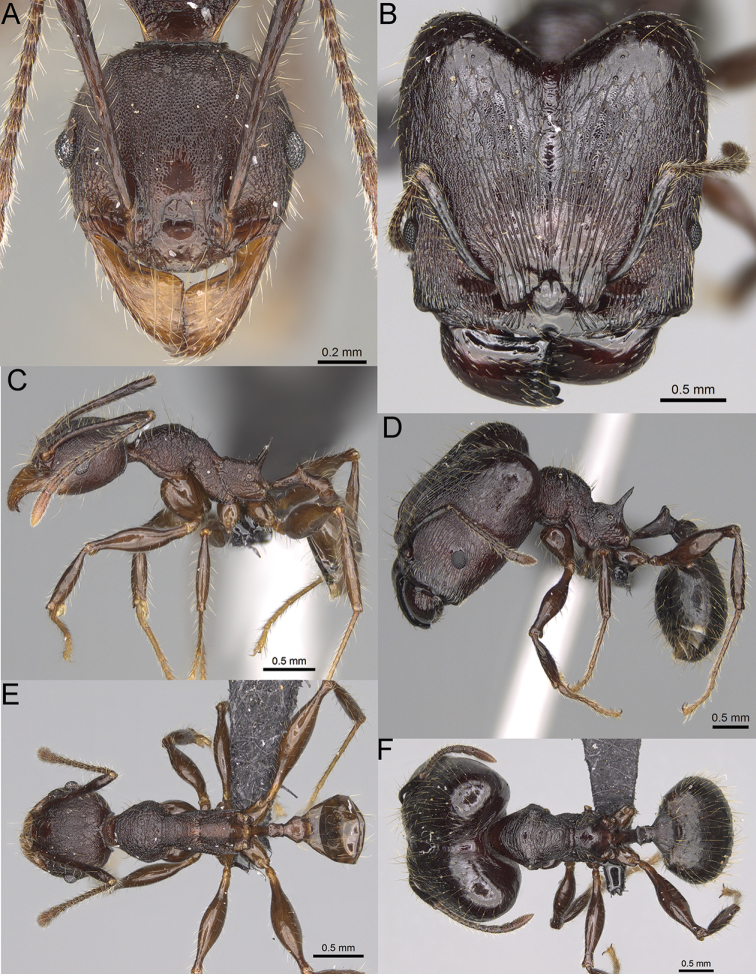
Pheidole
maizina sp. nov., full-face view (A), profile (C), and dorsal view (E) of paratype minor worker (CASENT0923223) and full-face view (B), profile (D), and dorsal view (F) of holotype major worker (CASENT0162231).